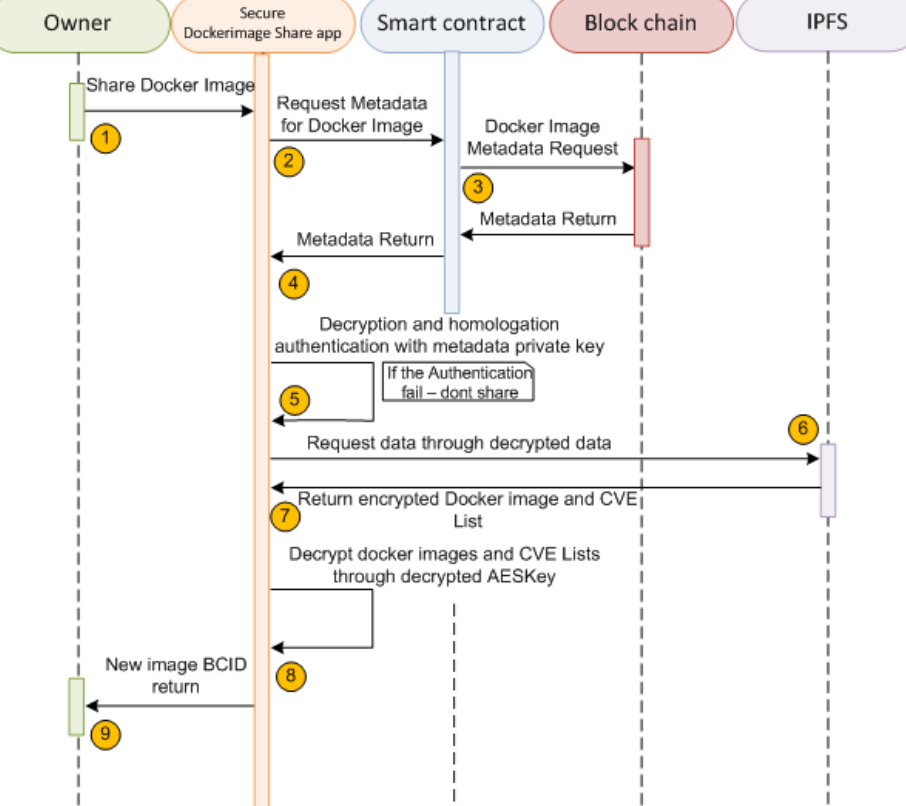
Figure 4. Sequence flow of the secure dockerimage